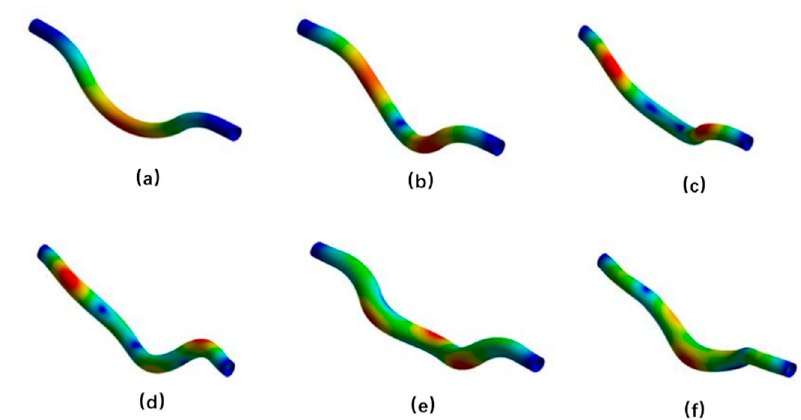
Figure 5. The first six order mode shapes of the micro-bend measuring tube. ( a ) First-order vibration mode; ( b ) Second-order vibration mode; ( c ) Third-order vibration mode; ( d ) Fourth-order vibration mode; ( e ) fifth-order vibration mode; ( f ) Sixth-order vibration mode.